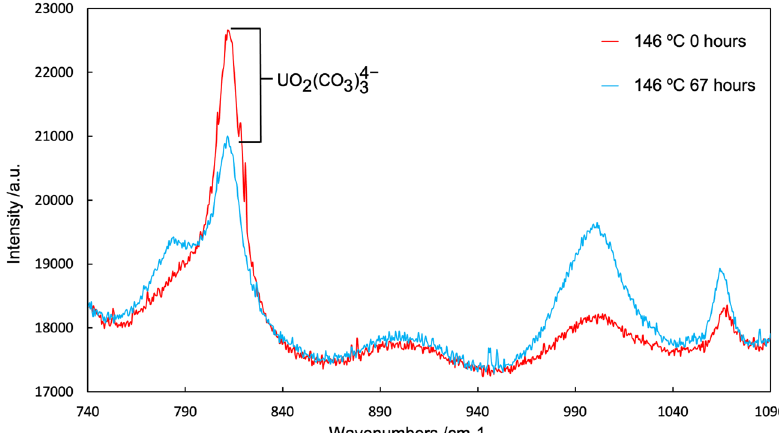
Fig. 1 Raman Spectra of a solution of 0.012 m UO 3 and 0.1 m NaHCO 3 collected at 146 °C before and after heating for 67 h. The U – O v1 stretching mode peak associated with the uranyl tricarbonate complex can be seen in both spectra but has diminished after 67 h. The broad peak visible in all spectra at ~792 cm − 1 corresponds to a water background signal. Peaks at ~1020 cm − 1 and ~1070 cm − 1 correspond to HCO 3 − /CO 3 2 − and indicate that carbonate was stable in solution. Note the increase in available carbonate after 67 h is consistent with the breakdown of uranyl tricarbonate